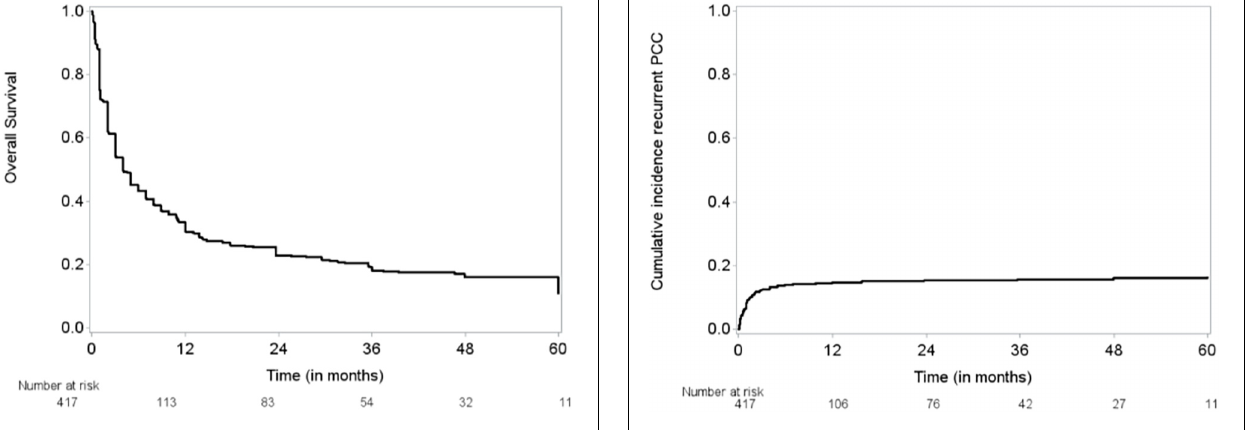
FIGURE 2 | Cumulative incidence of recurrent pericardial effusion requiring drainage by Aalen-Johansen estimator. Outcome for 1 patient was